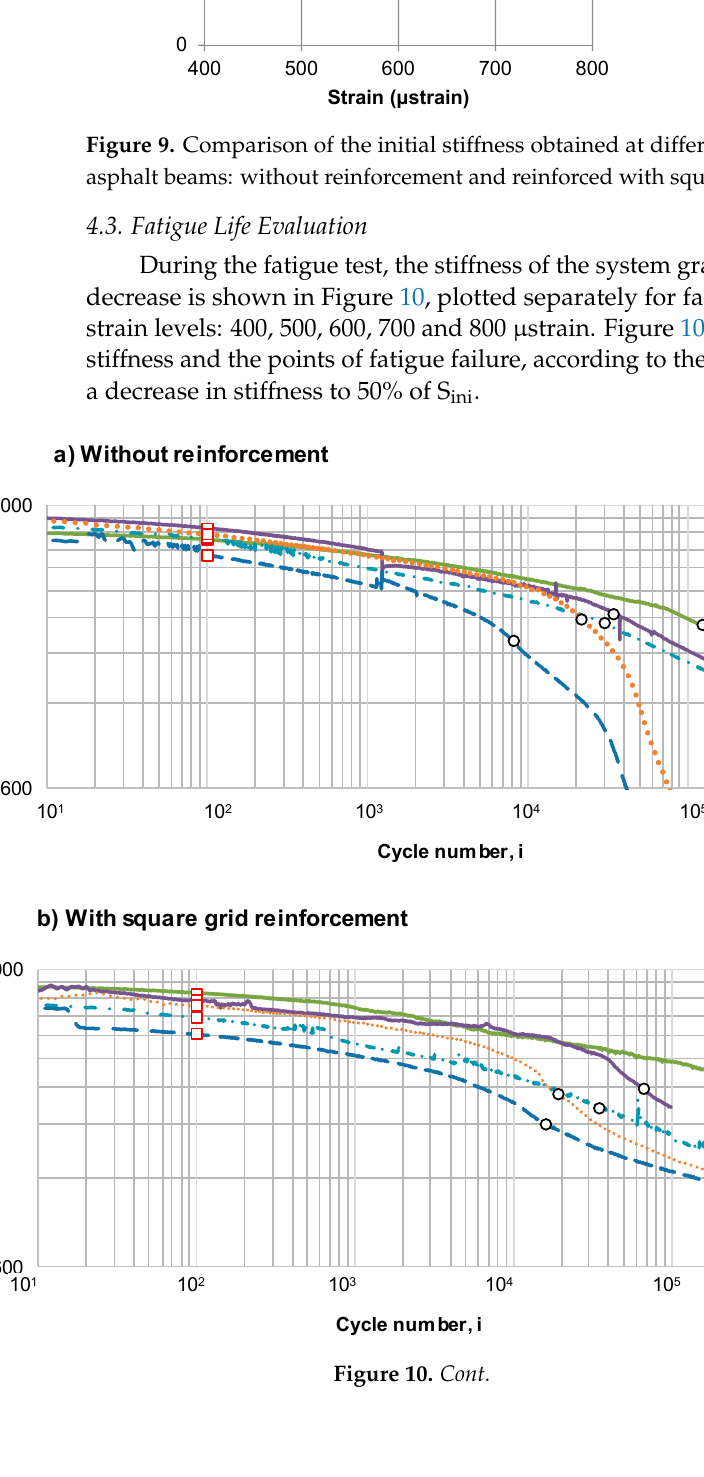
Figure 9. Comparison of the initial stiffness obtained at different strain values for double-layered asphalt beams: without reinforcement and reinforced with square and hexagonal geogrids.